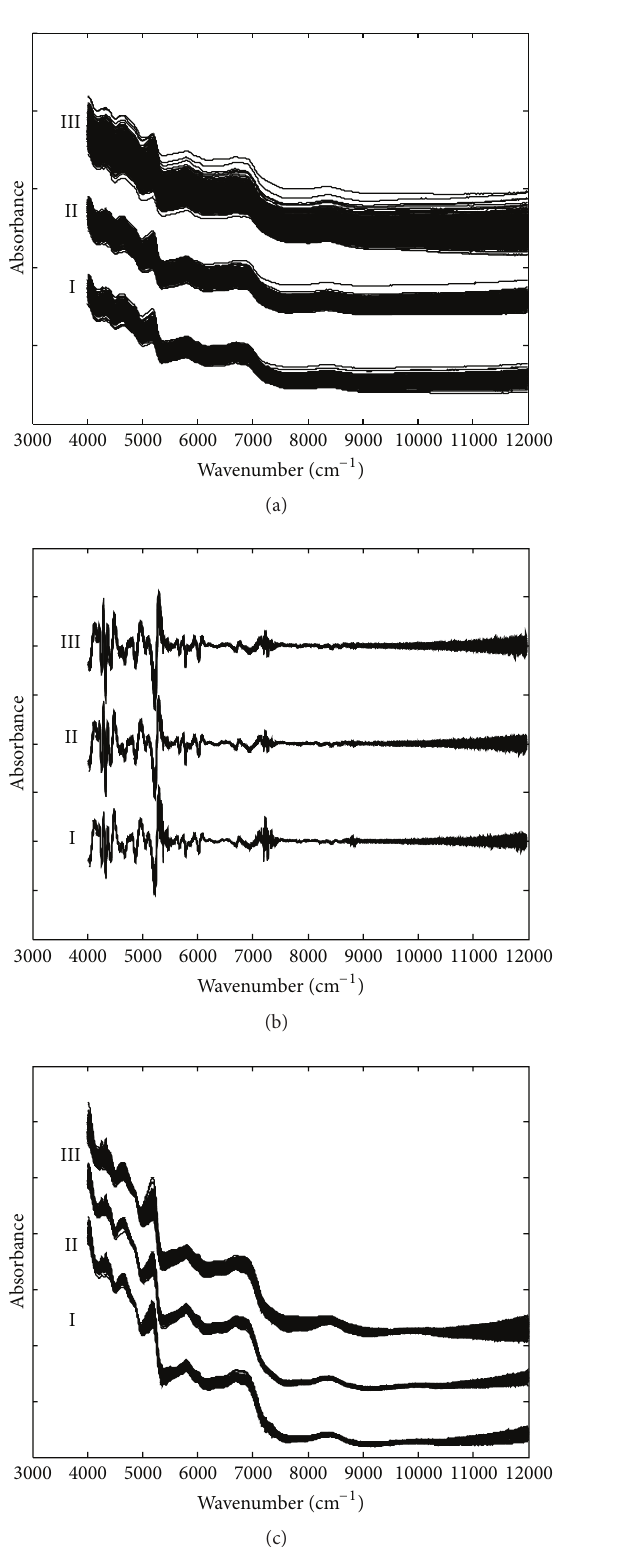
Figure 3: The Stahel–Donoho estimates (SDE) of outlyingness values for Longjing of grade I (a), grade II (b), and grade III